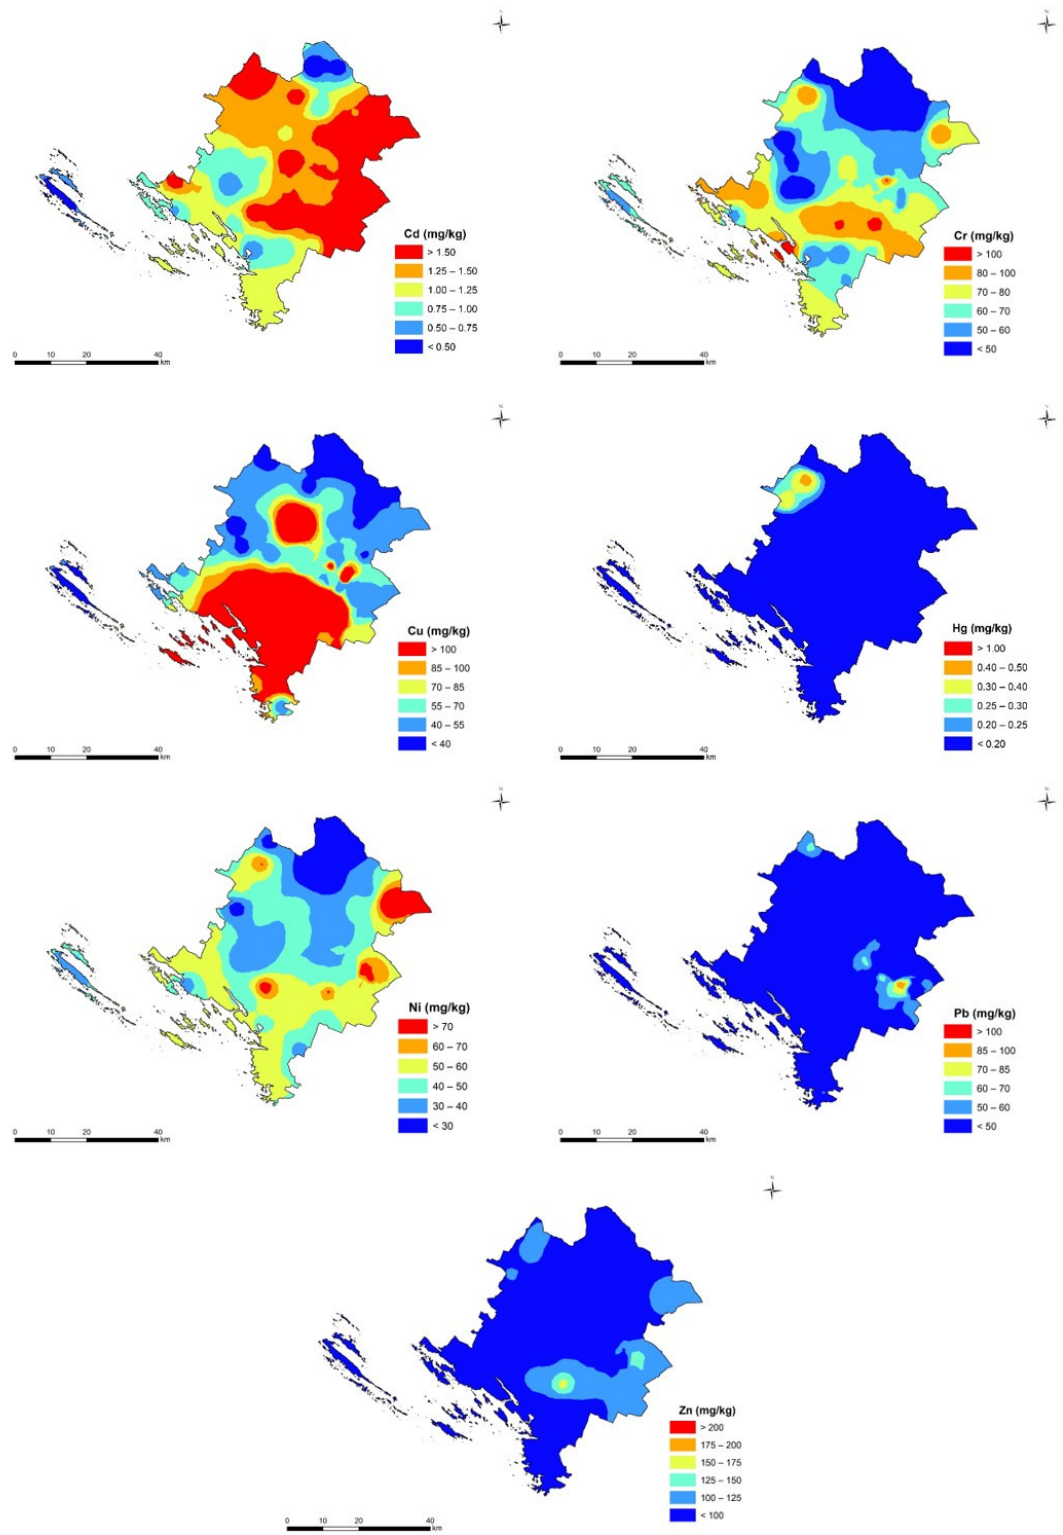
Figure 3. Interpolated maps of soil heavy metals.